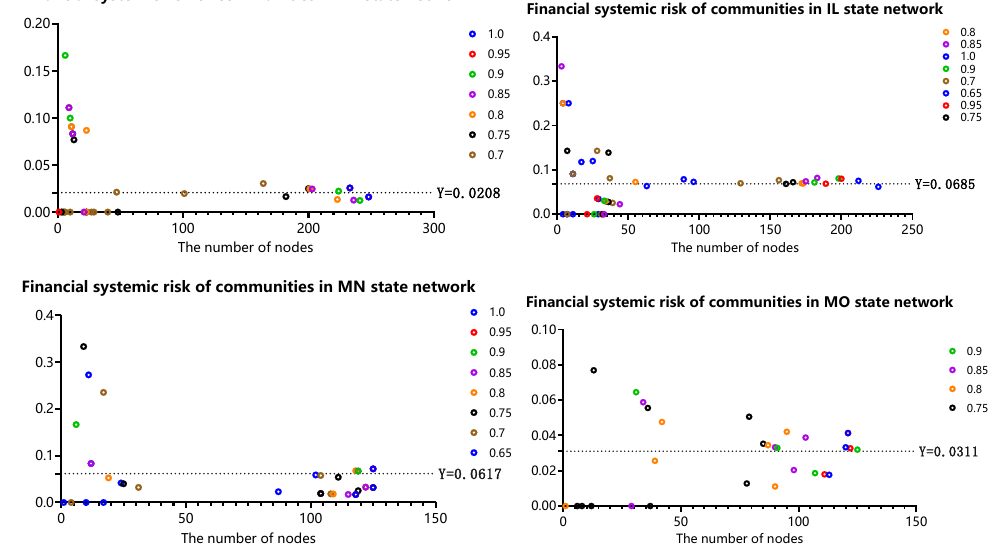
Figure 9. Relationship between systemic risk and the number of nodes in the